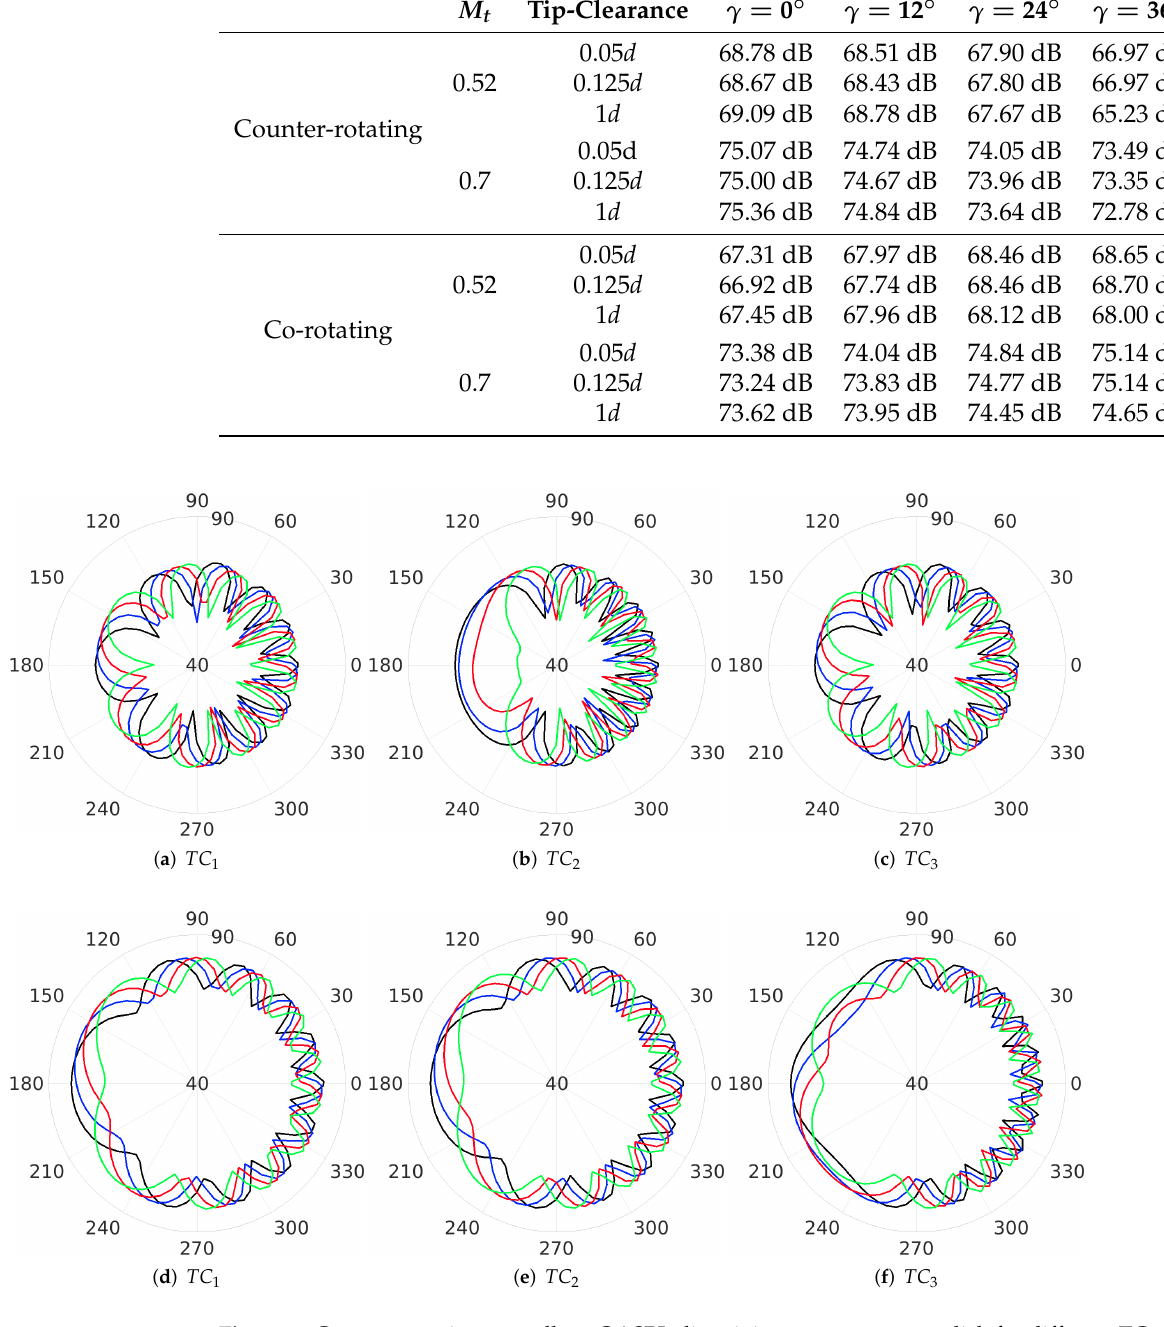
Figure 6. Counter-rotating propellers, OASPL directivity pattern on rotor disk for different TCs and different phase shifts (black line γ = 0 ◦ , blue line γ = 12 ◦ , red line γ = 24 ◦ , green line γ = 36 ◦ ); upper M t = 0.52, lower M t =